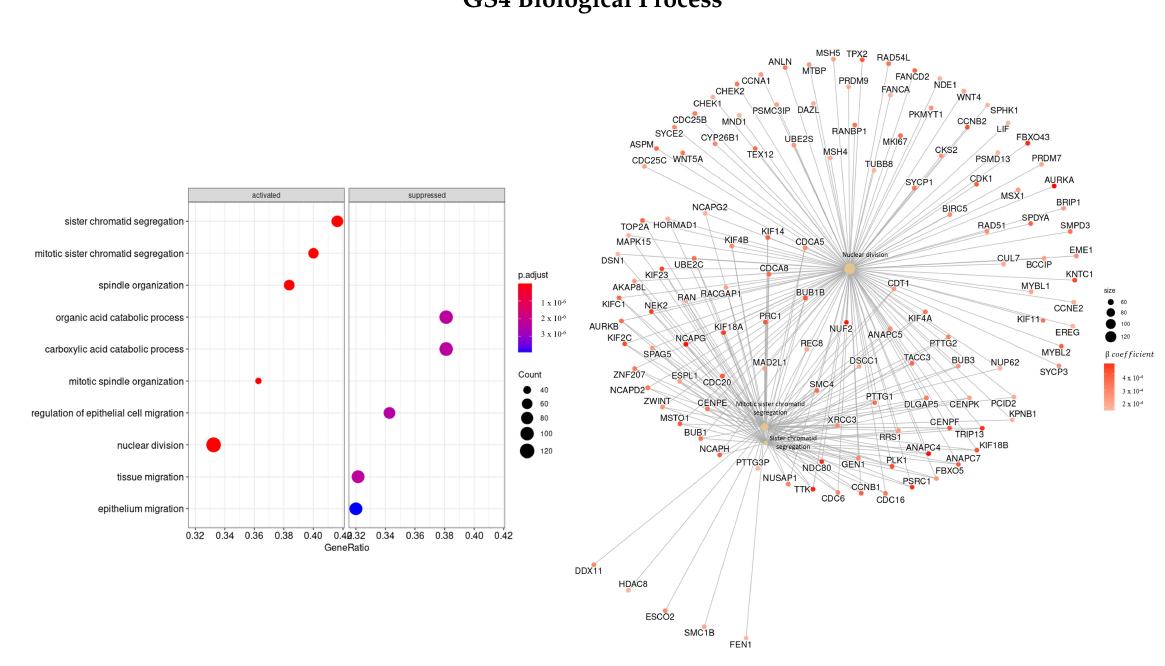
Figure 10. Gene ontology enrichment analysis regarding biological processes terms for a list of genes selected by TCox ranked by the β coefficients of the regression. The left panel shows a dot chart with the most significant BP terms. Right panel shows a gene-concept network plot of the three most enriched terms that depicts the linkages of genes and biological concepts as a network.